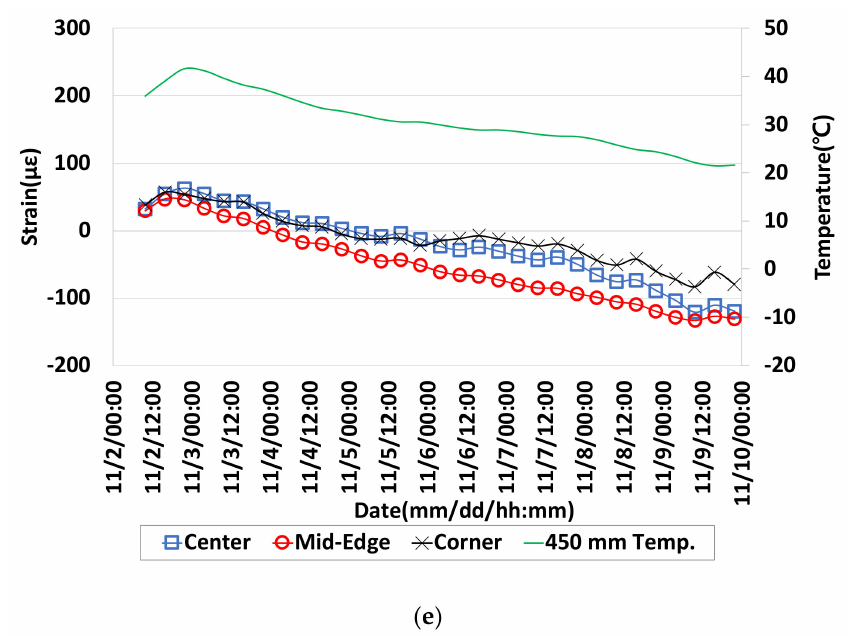
Figure 10. Concrete temperature and real strain according to slab position for the first seven days: